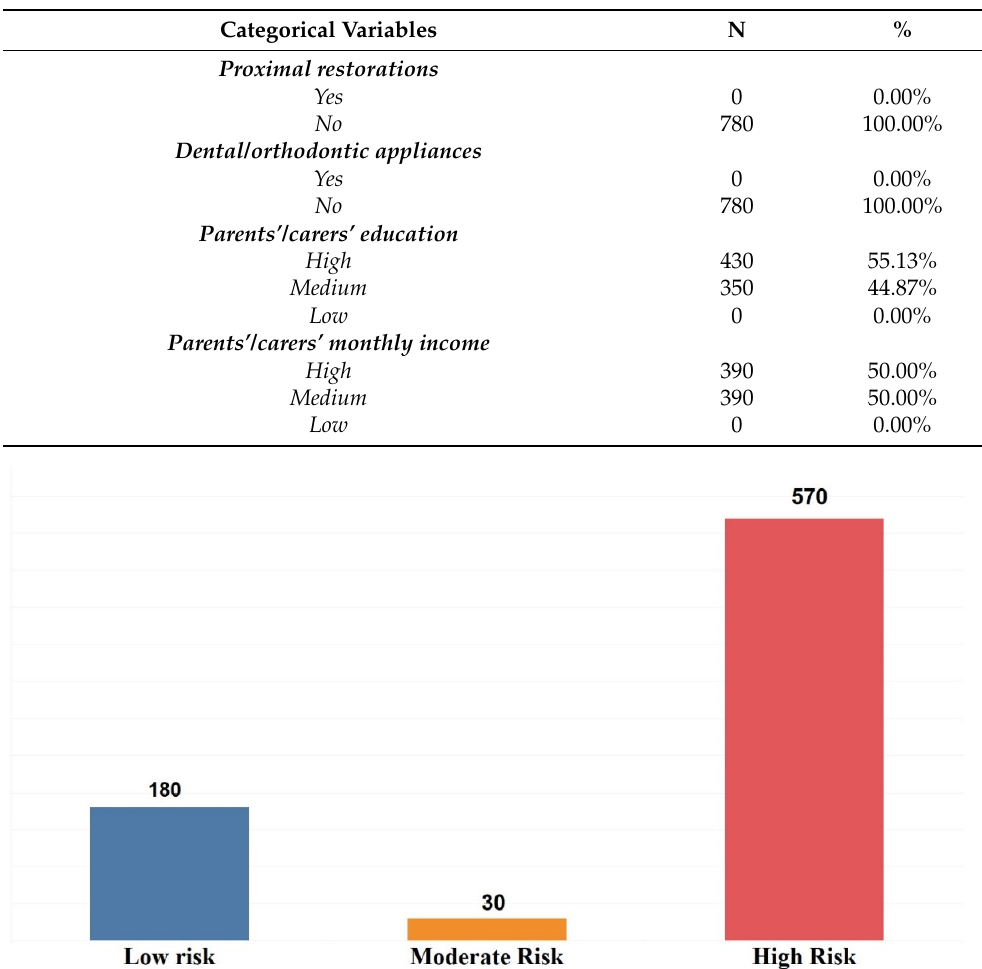
Figure 1. Number of patients in three levels of Low, Moderate, and High Risk.